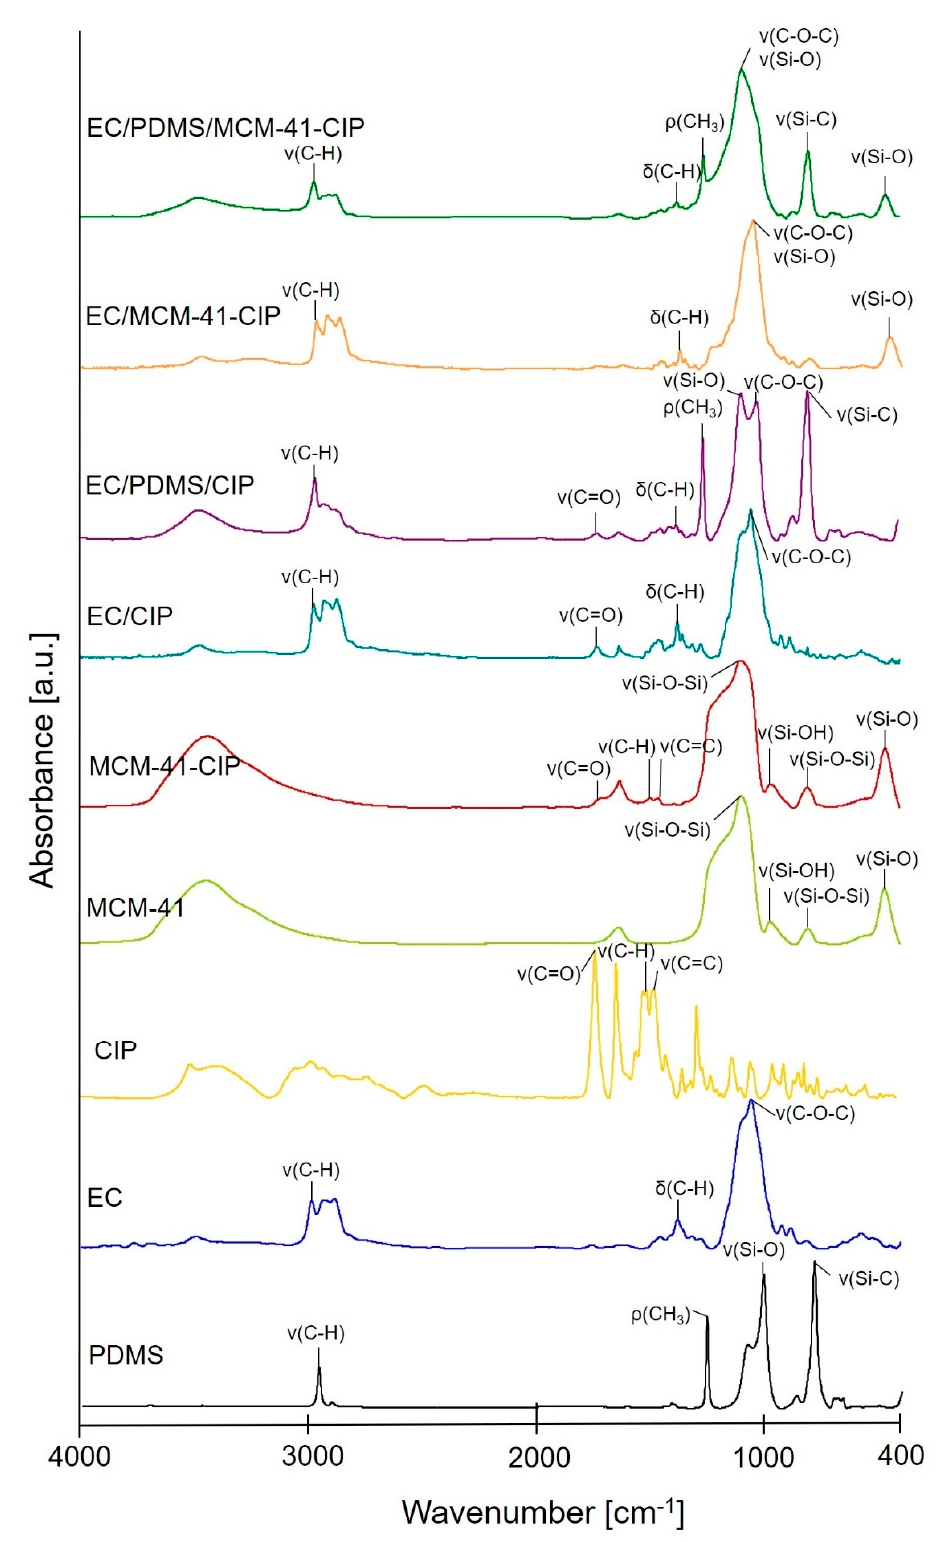
Figure 1. The FTIR spectra of composites: EC/CIP, EC/PDMS/CIP, EC/MCM-41-CIP, EC/PDMS/MCM-41-CIP and precursors: PDMS, EC, freeze-dried CIP, MCM-41, MCM-41-CIP (types of vibration: ν —stretching, δ —bending, ρ —rocking).